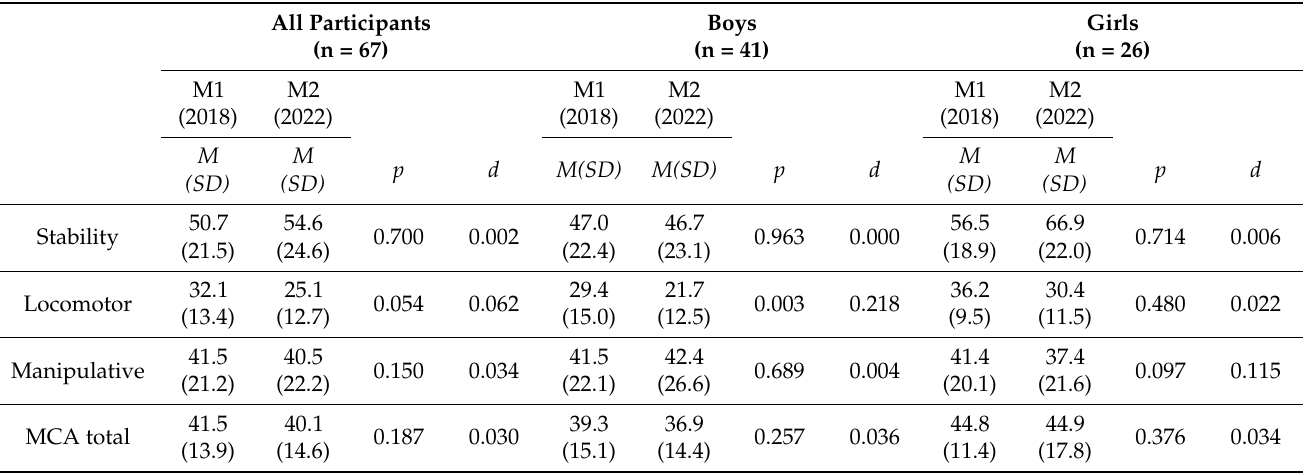
Table 2. MCA percentile values for Subscales and Total scores, by gender, and comparison between M1 (2018) and M2 (2022) data.